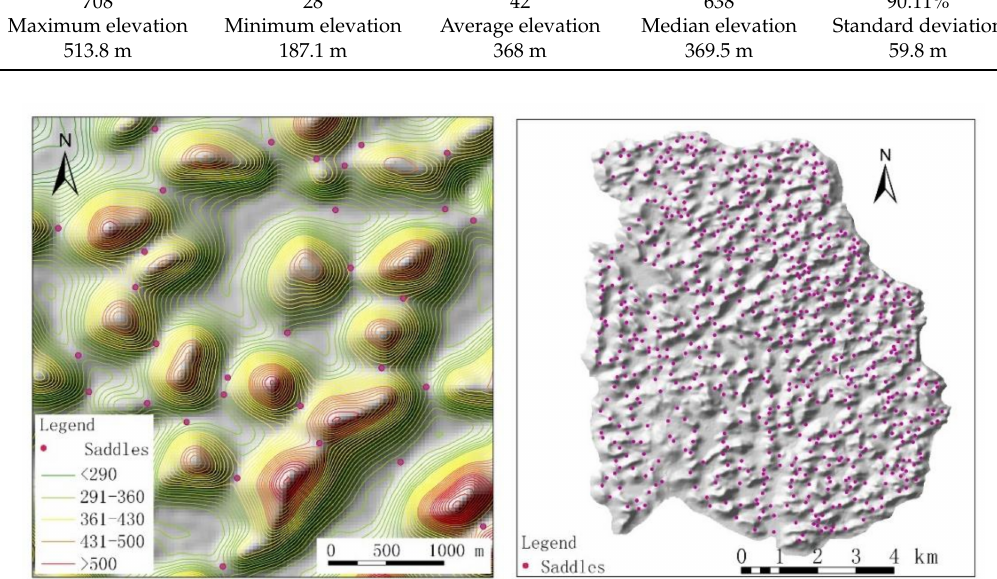
Figure 5. Extracted saddle